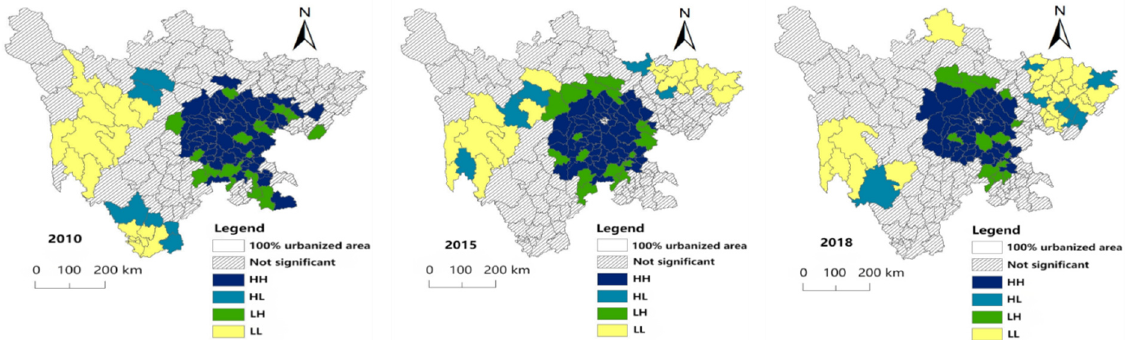
Figure 8. Cluster maps for local spatial autocorrelation of rural hollowing degree in 2010, 2015 and 2018.